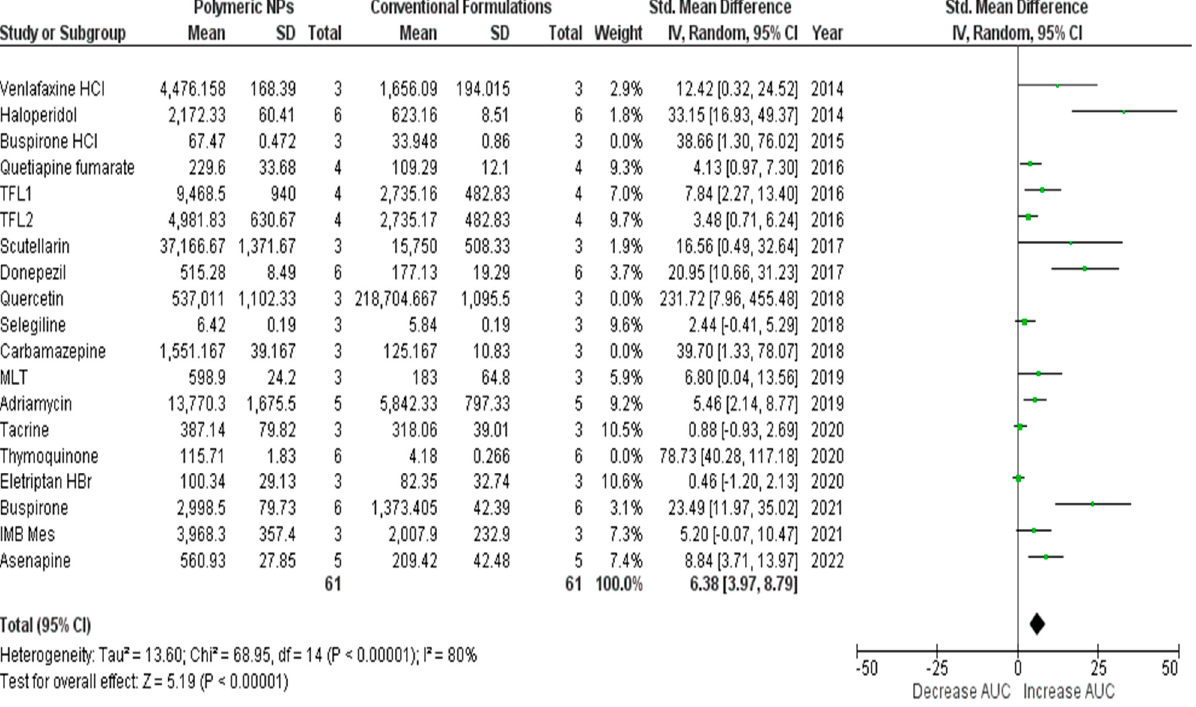
Figure 5. Forest plot of optimized meta-analysis for the studies: [1–3,5–8,11–17,19], according to Review Manager software.